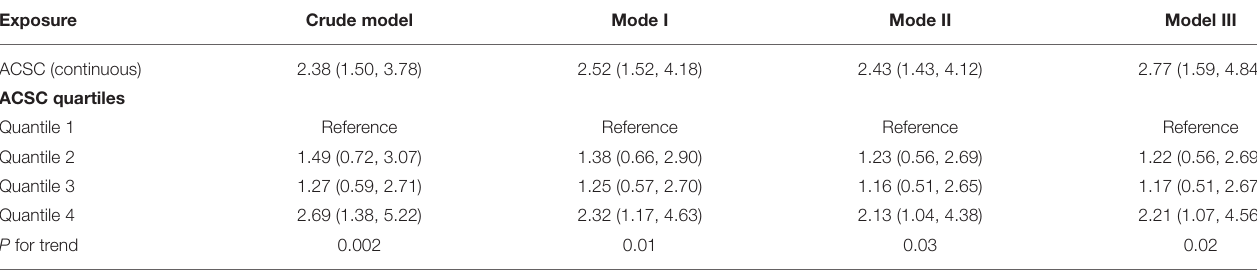
TABLE 3 | Multivariate regression analysis of ACSC and 30-day mortality.